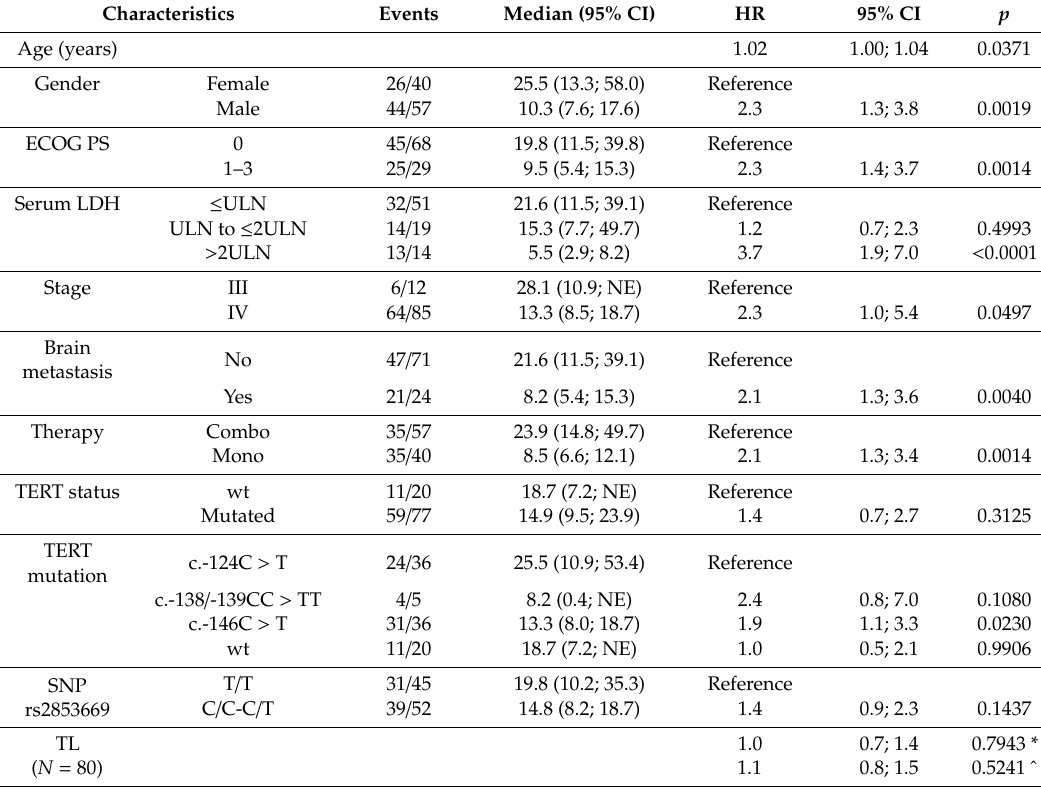
Table 3. Univariate Cox proportional hazards models of overall survival.